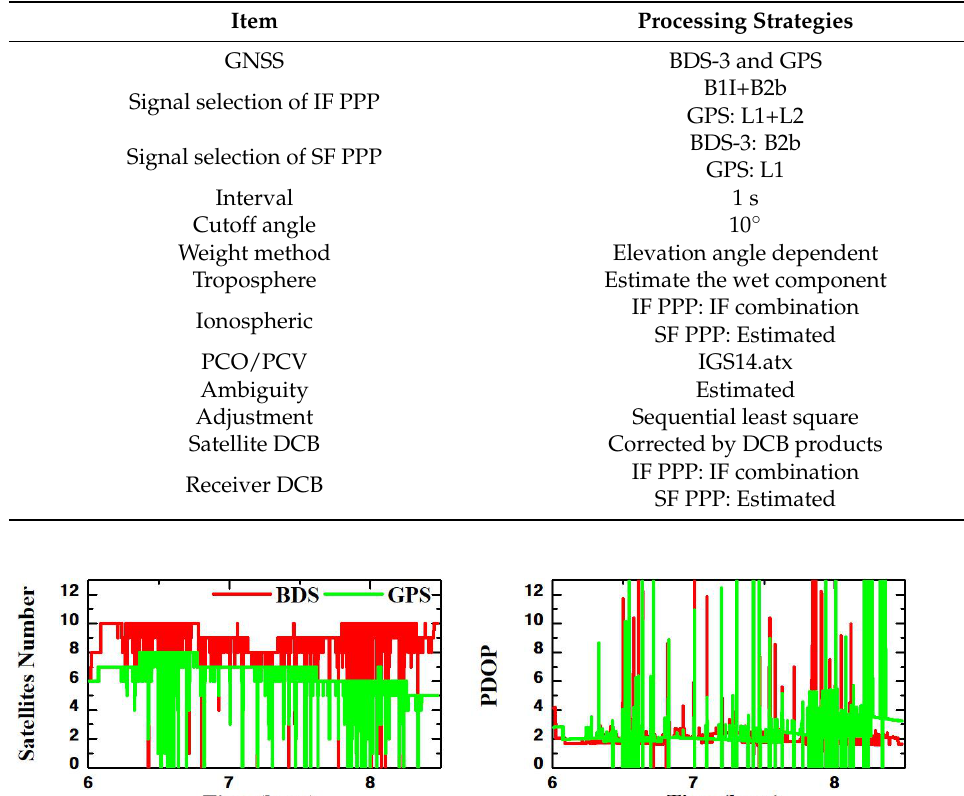
Table 7. PPP processing strategies of dynamic test.